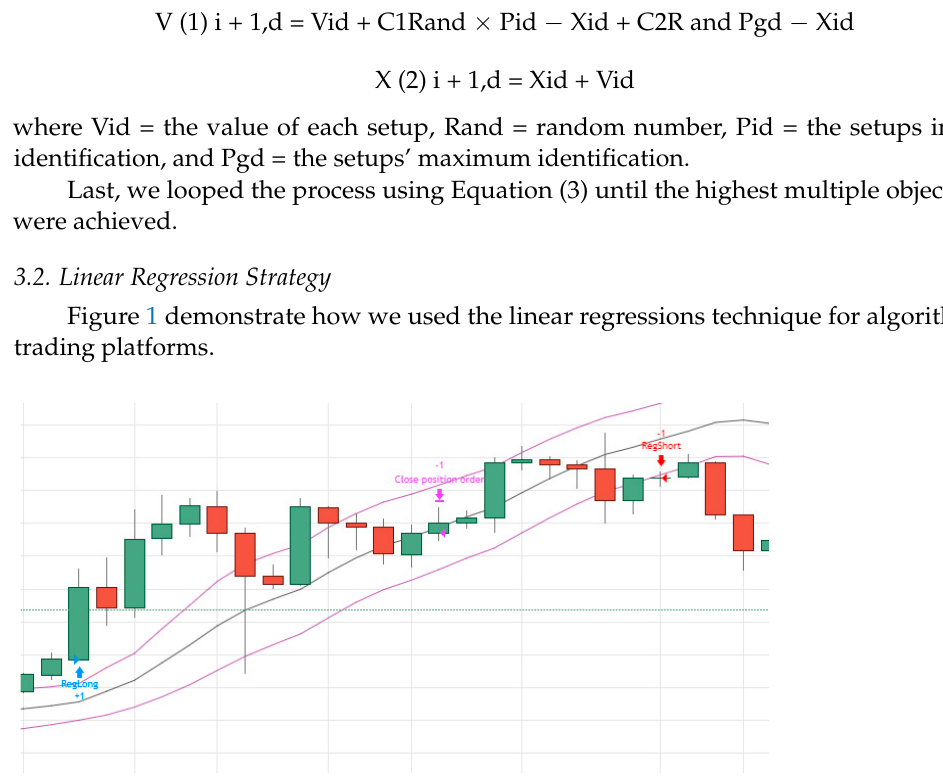
Figure 1. Linear regression algorithmic trading strategy. Notes: Every candlestick in Figure 1 represent the high/low open/close of the commodity futures’ daily prices. The middle line in Figure 1 represent the linear regression line, while the other two lines represent one standard deviation from